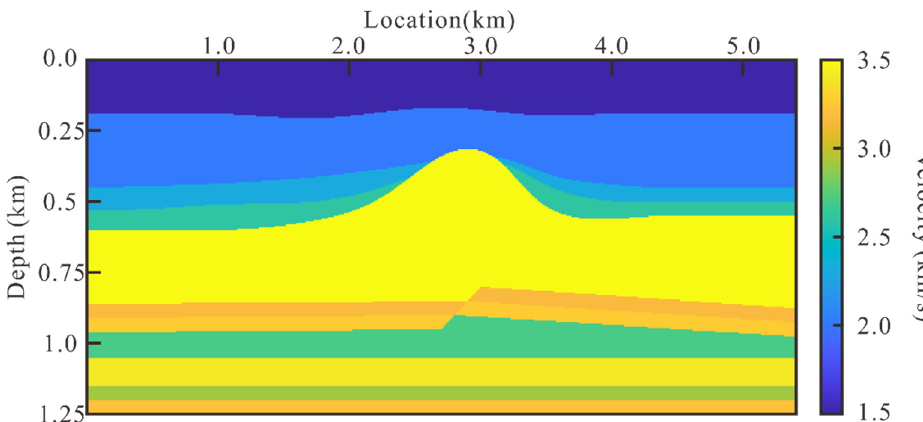
Figure 5. The demonstration of the saltdome